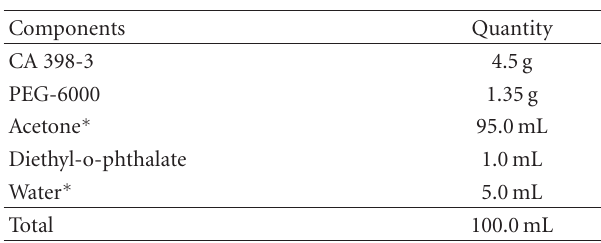
Table 3: Coating